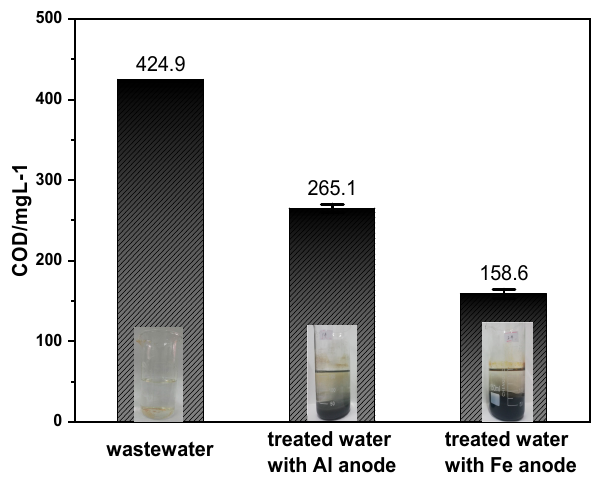
Figure 3. Effect of anode materials for EC treatment on mixed wastewater COD value (cathode Figure 3. E ff ect of anode materials for EC treatment on mixed wastewater COD value (cathode material: material: Stainless steel, current density: 13.74 mA/cm 2 , pH: 7.1, electrolysis time: 50 min). Stainless steel, current density: 13.74 mA / cm 2 , pH: 7.1, electrolysis time: 50